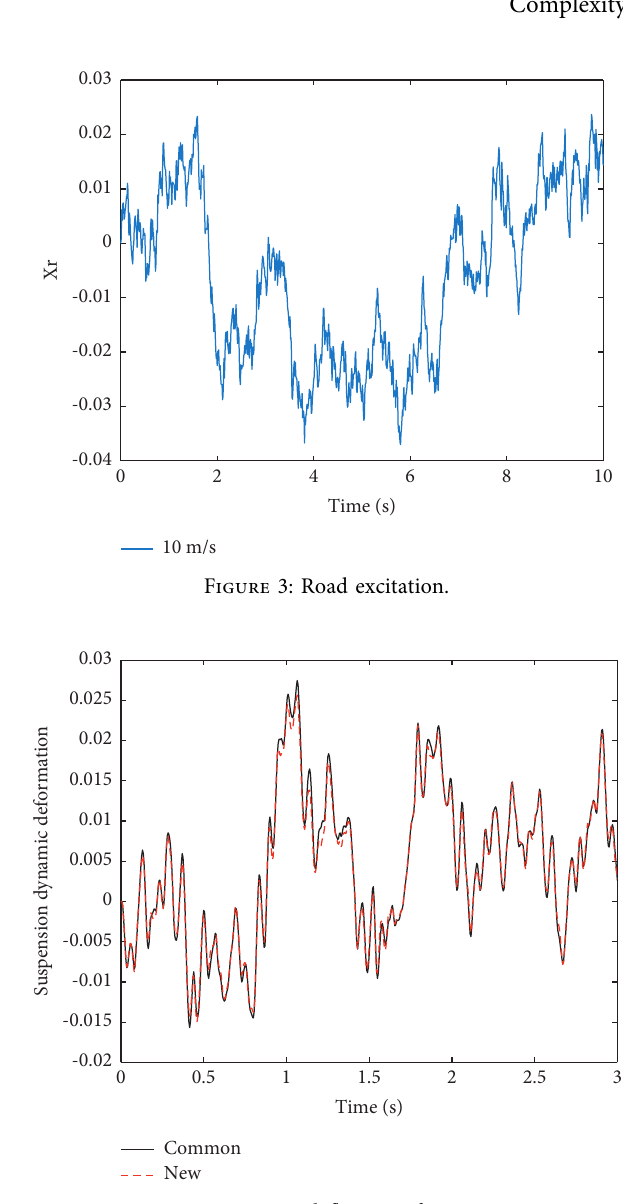
Figure 4: Dynamic deflection of